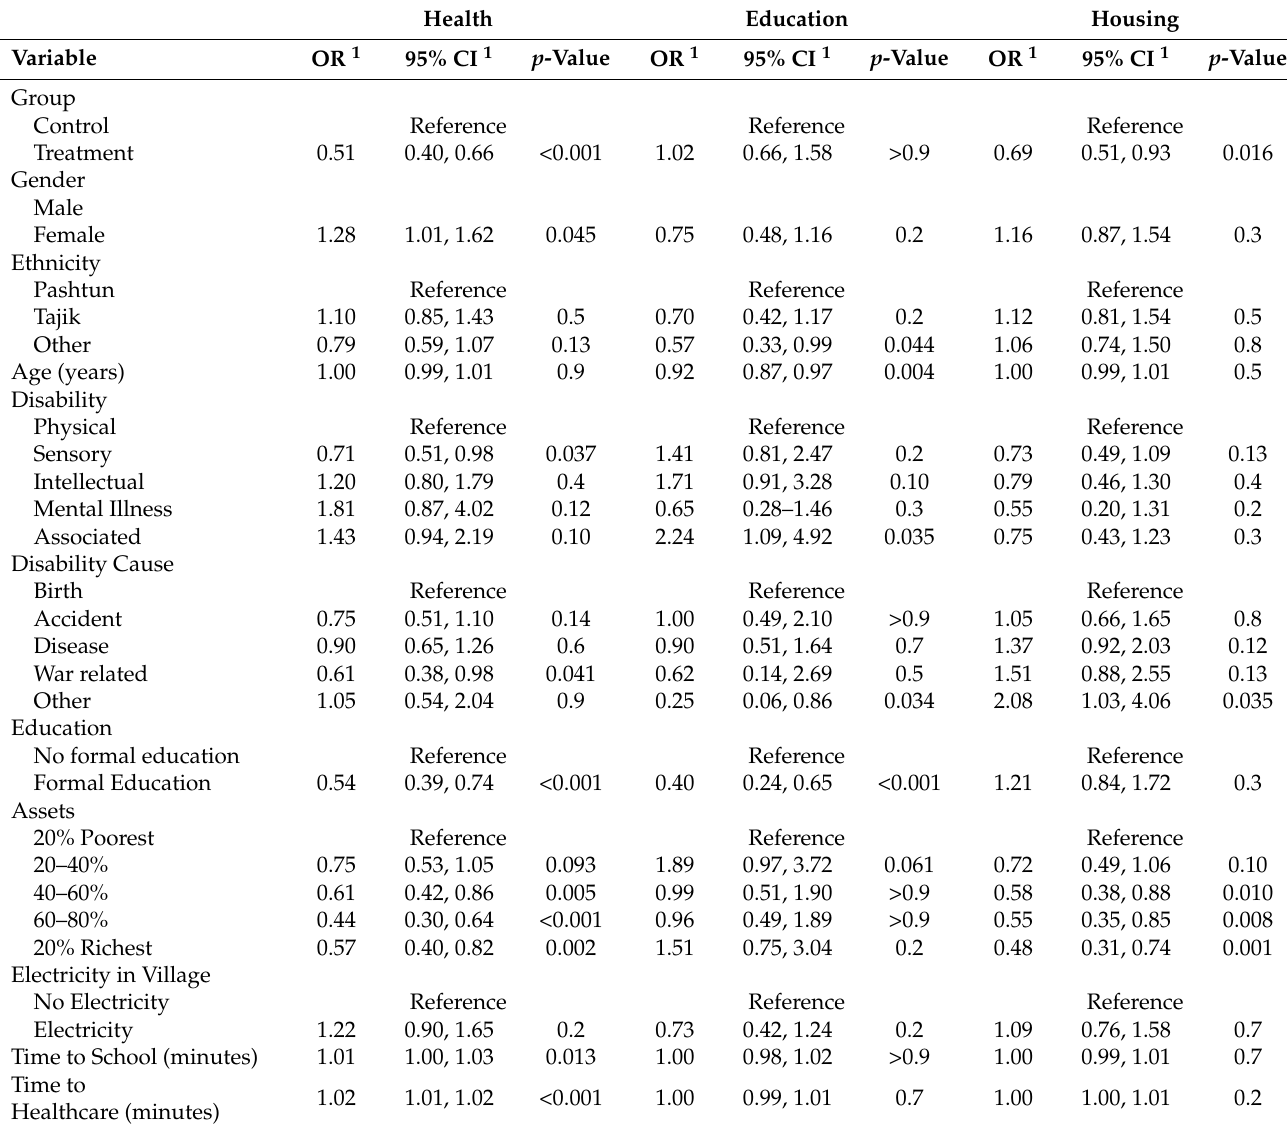
Table 4. Results of logistic models on health, education, and housing needs.